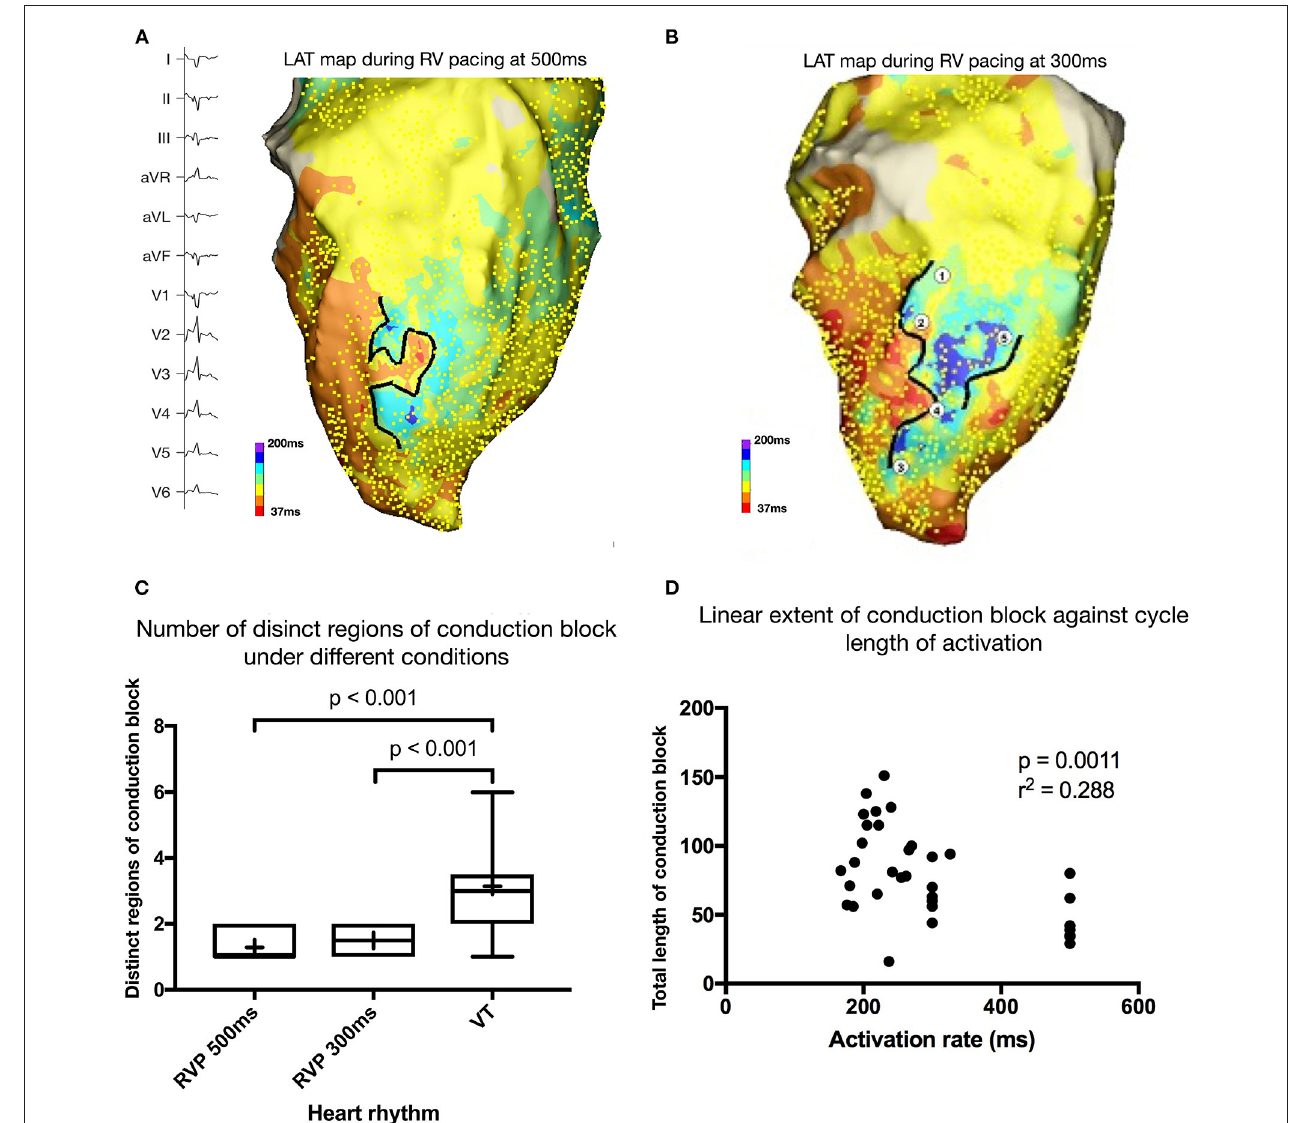
FIGURE 1 | (A) Activation map during right ventricular (RV) pacing at 500ms. Yellow dots mark the point at which activation time was recorded. Black line represents linear conduction block during pacing at this cycle length. (B) Activation map during right ventricular (RV) pacing at 300ms. (C) Number of distinct regions of conduction block during different heart rhythms (RV pacing at 500ms and 300ms and during VT). (D) Scatter plot of extent of linear endocardial conduction block and activation rate during pacing or VT.